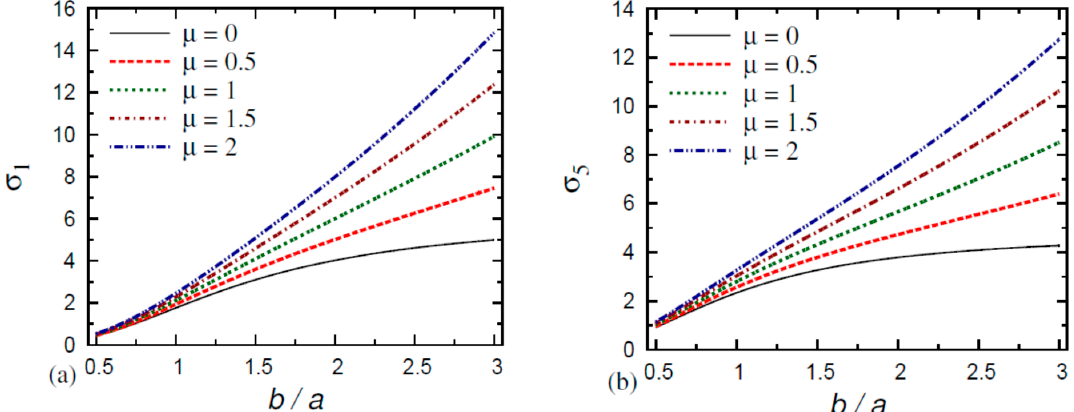
Figure 7. The through the thickness distributions of the stresses in FG square nanoplates for di ff erent values of small length scale µ . ( a ) The in-plane stress σ 1 and ( b ) the shear stress σ 4 ( k = 1, a / h = 10).